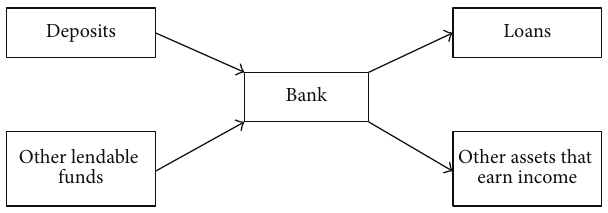
Figure 3: Intermediation model.